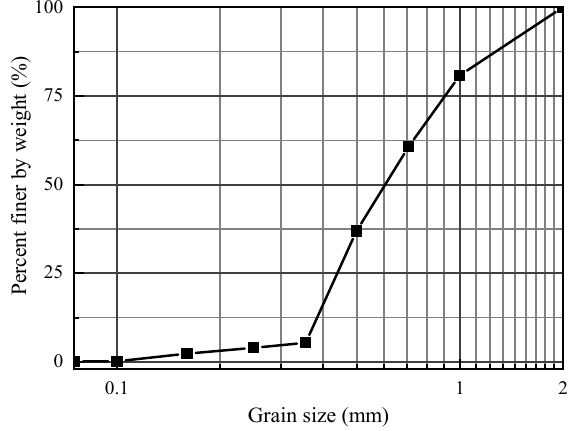
Figure 2. Particle size distribution curve of coral sand samples.